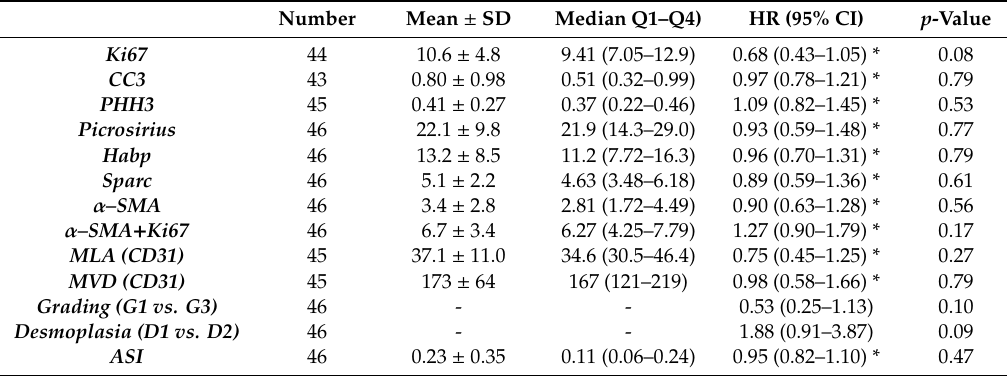
Figure 2. Proliferation and apoptosis markers in KPC mice. Proliferation was investigated via ( A ) Ki67 and ( B ) PHH3. ( C ) IHC staining and subsequent quantification enabled di ff erentiation between high- and low-expressing tumor tissue, respectively. Scale equals 50 µ m. ( D ) Apoptotic rate assessed via CC3 expression. Table 2. Results from univariable histopathological analysis in KPC tumor tissue for all analyzed parameters. Significance of association with survival was calculated by univariate Cox regression model. Abbreviations: SD, standard deviation; CI, confidence interval; IQR, interquartile range; HR, hazard ratio; MVD, mean vessel density; MLA, mean lumen area; * for continuous variables, HR and 95% CI presented for increase corresponding to